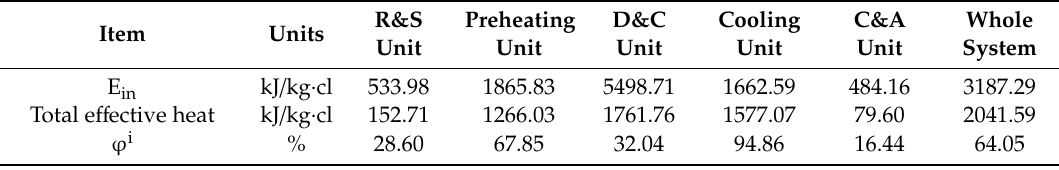
Table 3. Thermal e ffi ciencies of subunits of a representative 5000 MT / D production line.